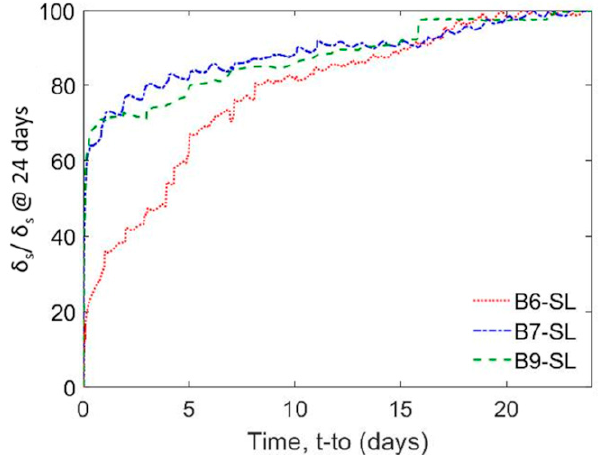
Figure 17. Percent increase in deflection with time beams series II.